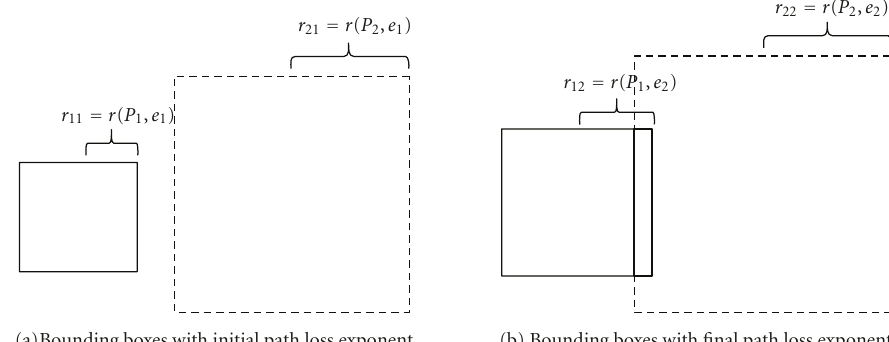
Figure 7: Iterative bounding boxes.